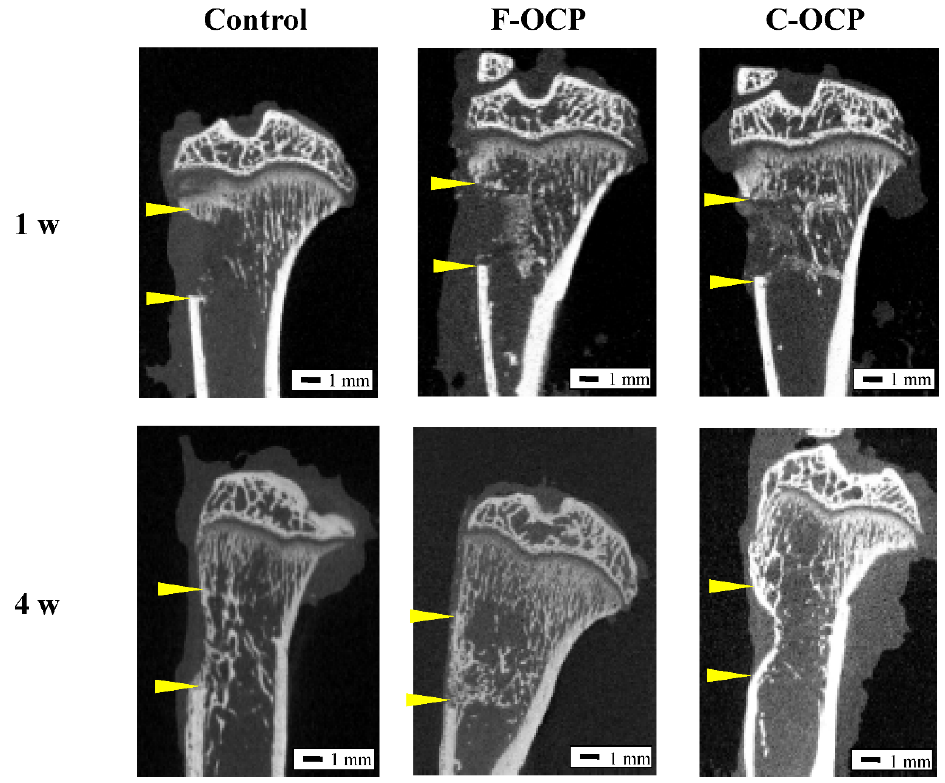
Figure 5. Micro-CT images of rat tibia at one and four weeks after implantation of F-OCP and C-OCP granules. Control group means bone defect without material implantation. Bars in the panels represent 1 mm. Yellow arrowheads indicate the edge of the